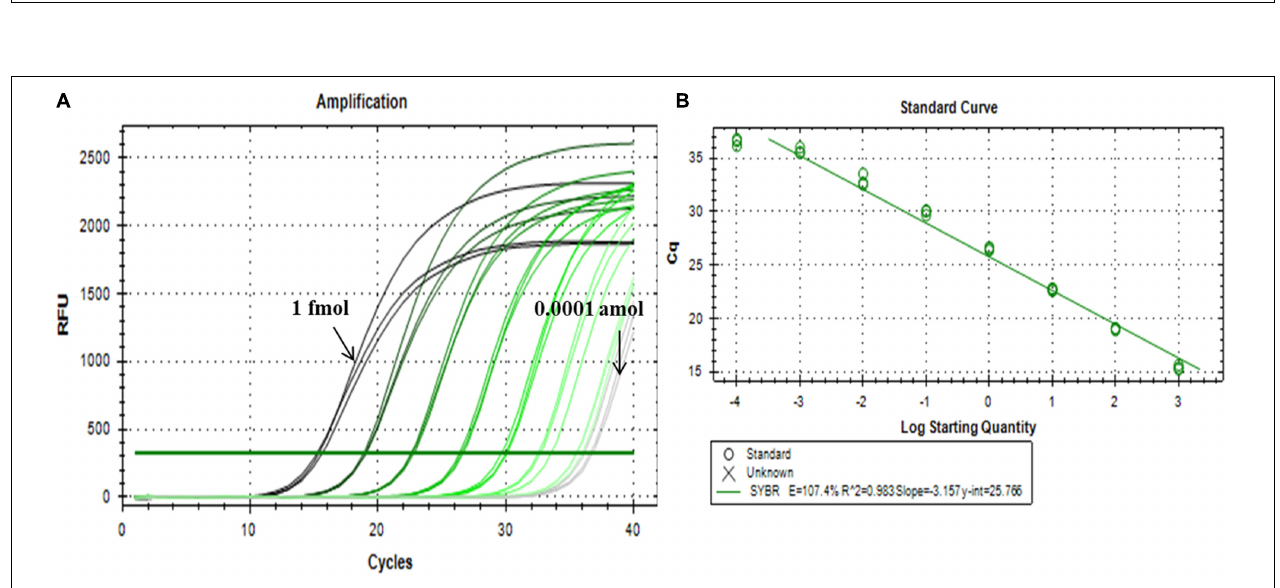
FIGURE 3 | Dynamic range and sensitivity of the synthetic miR156b assay over eight orders of magnitude. (A) From left to right, the concentrations of synthetic miR156b is 1 fmol, 100 amol, 10 amol, 1 amol, 0.1 amol, 0.01 amol, 0.001 amol, and 0.0001 amol. (B) Dynamic relationship between C T value and log of miR156b concentration; E : polymerase chain reaction (PCR) efficiency, R 2 : squared regression coefficient of the standard curve.